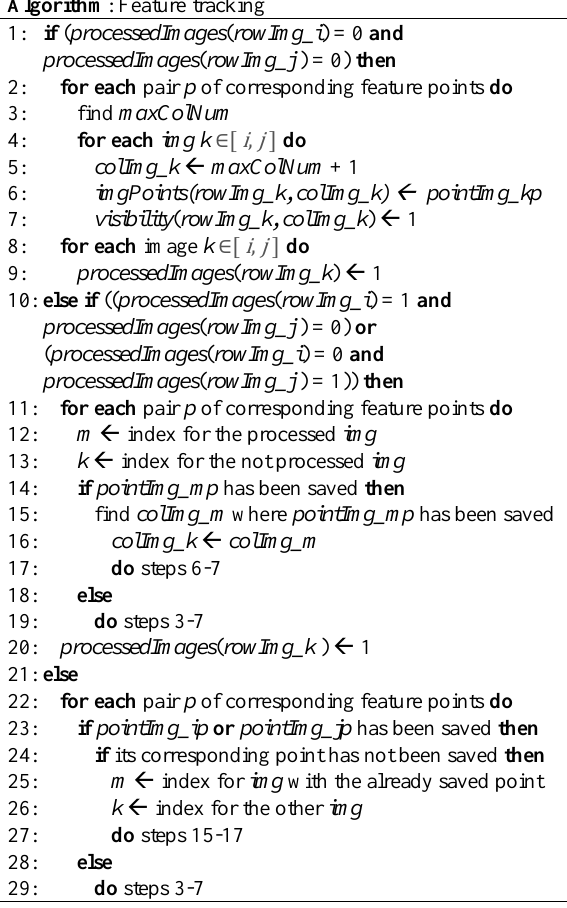
Figure 2. Feature tracking algorithm applied for each image